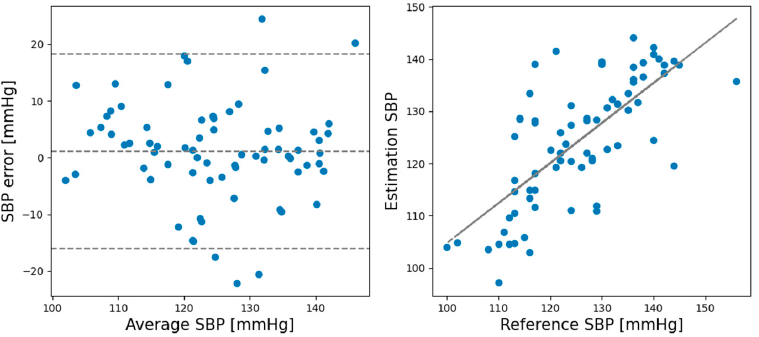
Figure 7. Bland–Altman plots for SBP estimations result made by CNN model in the recovery session.